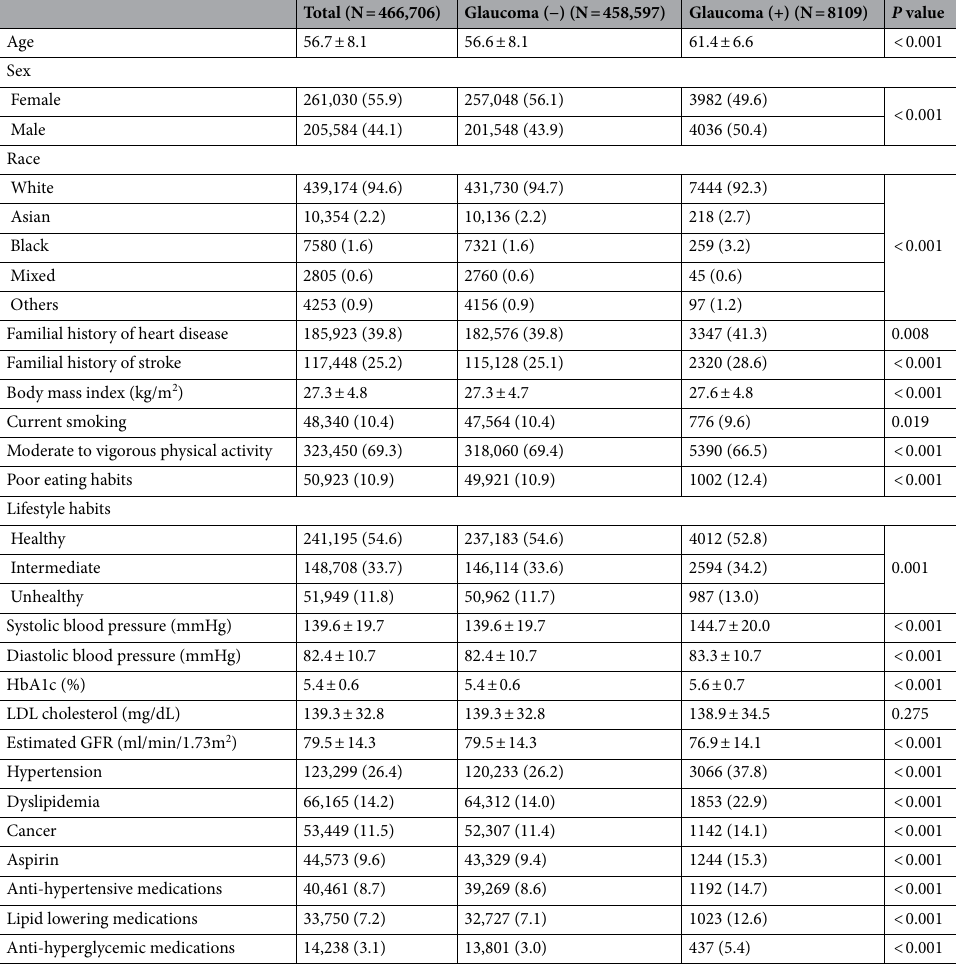
Table 1. Baseline characteristics of the study population. Data are n (%) or mean (SD). CVD cardiovascular disease, GFR glomerular filtration